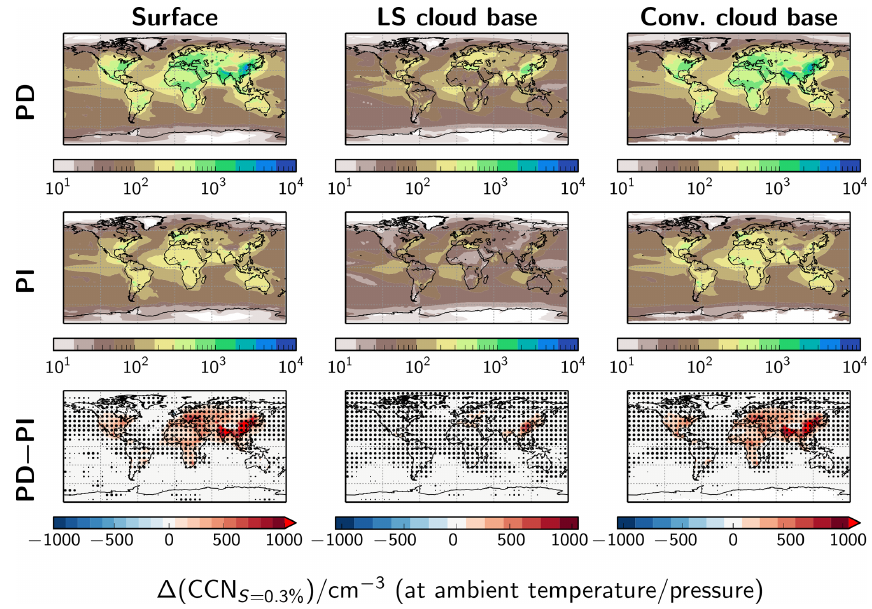
Figure 1. Annual mean CCN concentrations at the surface (left), large-scale cloud base (centre) and convective cloud base (PD–PI) from simulations using CCFM convection under PD (top row) and PI (middle row) aerosol emission scenarios, and the difference (bottom row). Specifically, these come from the CCFMall_ari simulations (see Table 1); however the difference in the others is small. (PD: present- day aerosol; PI: pre-industrial aerosol; stippling indicates areas where the PD–PI difference is statistically significant at the 95%